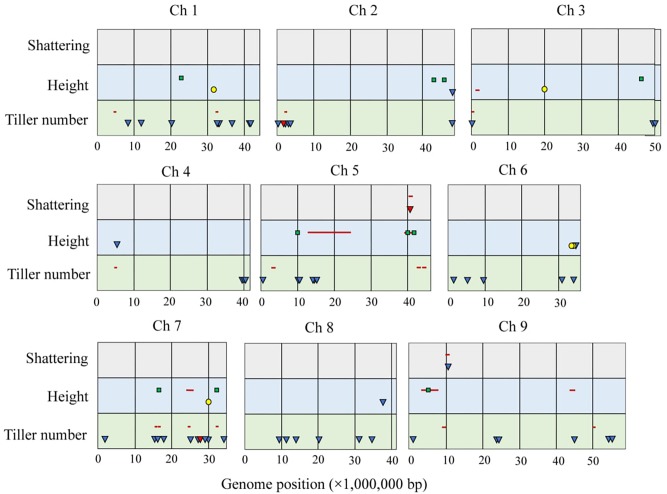
Summary of domesticated and modern improvement loci across the Setaria genome. Each box represents an individual chromosome, where the values along the x-axis are physical position in the foxtail millet genome, y-axis indicates different traits. In each trait, the first row represents the foxtail millet × green foxtail F7 RIL population used in studies of Doust et al. (2014a) and Mauro-Herrera and Doust (2016) (QTLs displayed by red bars), and Feldman et al. (2017) (QTLs indicated by green squares). The second row represents the foxtail millet population studies of Jia et al. (2013b) (blue triangles correspond to GWAS signals of modern improvement, and red triangles show selective sweeps), and Fang et al. (2016) (QTLs represented by yellow circles).